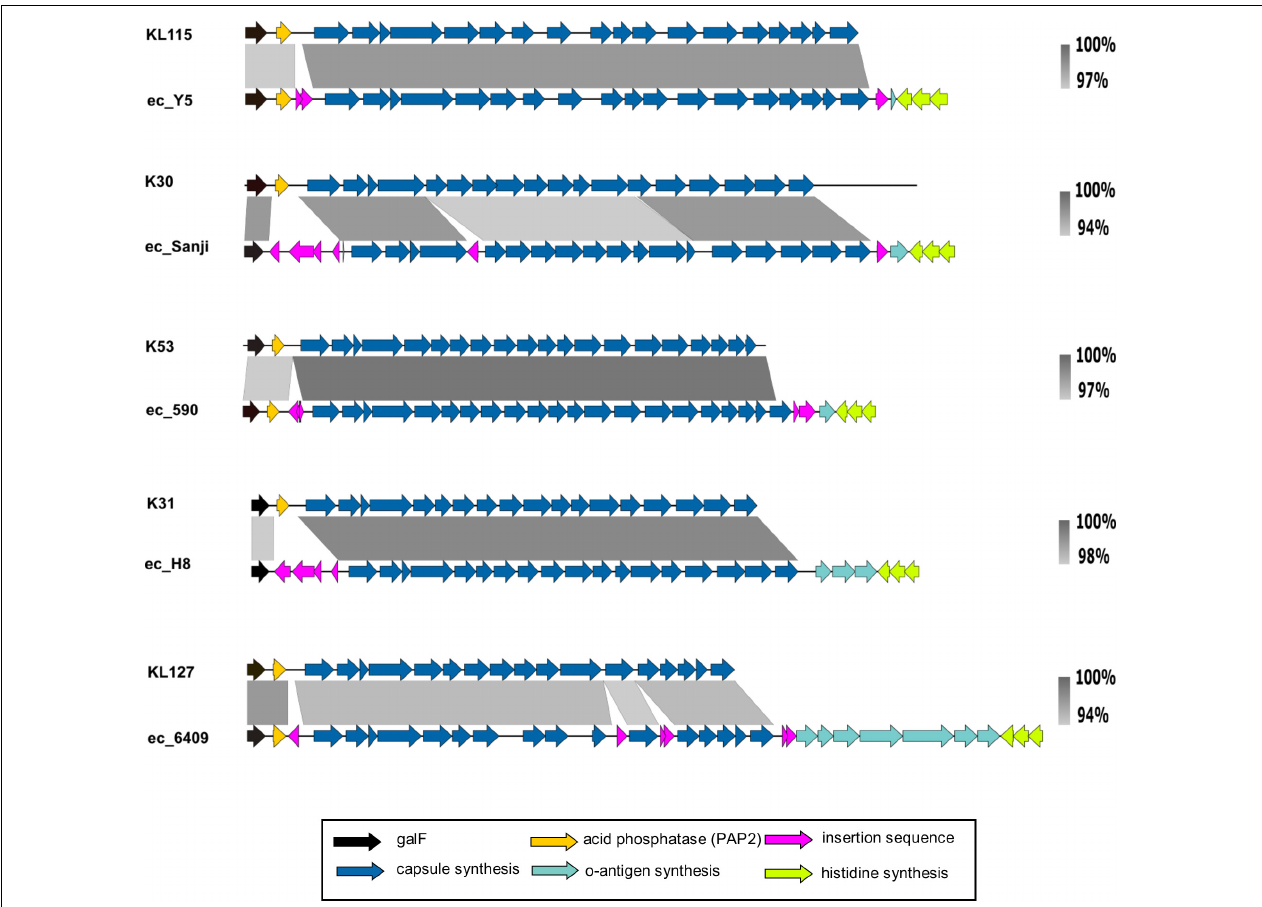
FIGURE 6 | Group 1 capsule loci of representative E. coli ‘O89m’ strain capsule loci aligned to matching Klebsiella reference capsule sequences. Group 1 capsules of O89m strains display high similarity to those in Klebsiella . The nucleotide sequences between the capsule (blue) and histidine (lime green) biosynthetic genes match to the 3 (cid:48) ends of either O8 or O9 O-antigen